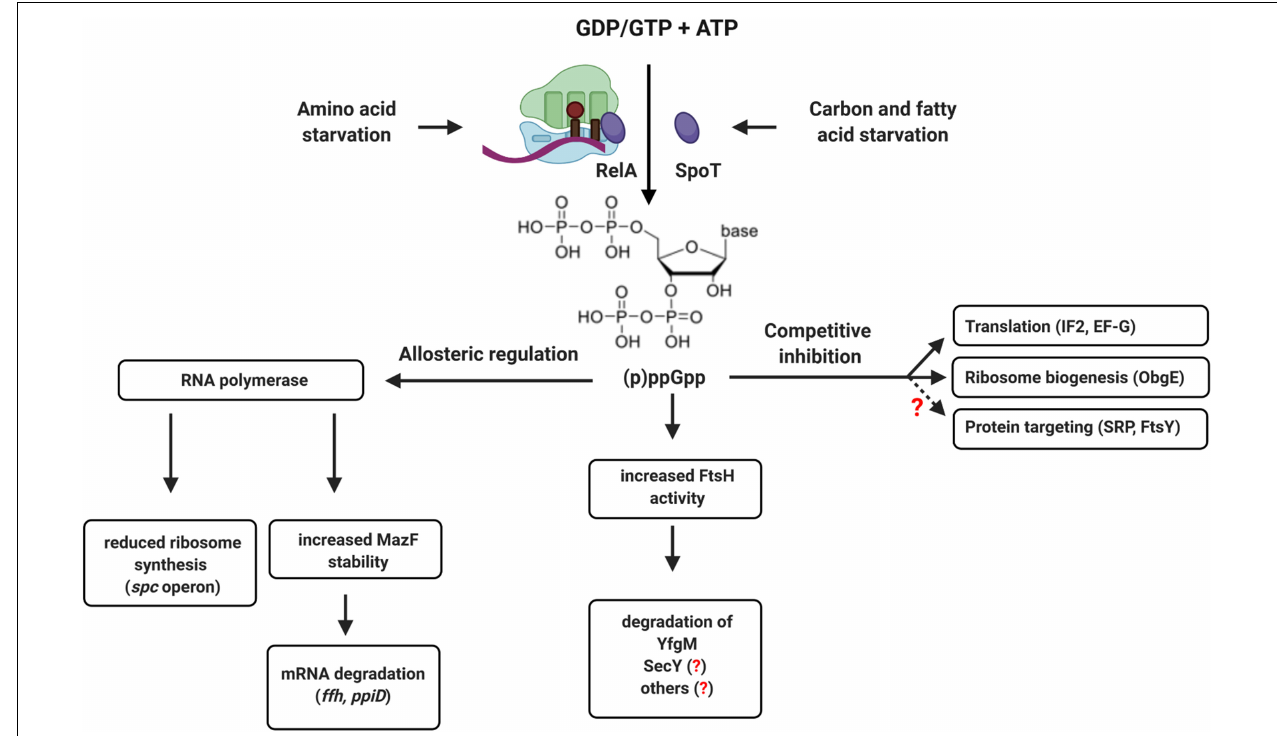
FIGURE 12 | (p)ppGpp-dependent regulation of translation and protein transport in bacteria. The alarmones ppGpp and pppGpp are synthesized upon amino acid starvation by the ribosome-associated protein RelA or by the cytosolic protein SpoT upon carbon or fatty acid starvation. Allosteric regulation of RNA polymerase by (p)ppGpp reduces ribosome biogenesis and increases the stability of the ribonuclease MazF, which degrades multiple mRNAs. This includes the mRNA encoding for Ffh, the protein component of the bacterial SRP, or the ppiD mRNA, encoding for an accessory subunit of the SecYEG translocon. (p)ppGpp also increases the activity of FtsH, which can degrade SecY and YfgM. YfgM forms a complex with PpiD that associates with the SecYEG translocon. Whether SecY is specifically degraded by FtsH upon (p)ppGpp accumulation is not shown yet. (p)ppGpp also acts as competitive inhibitor of GTP-binding proteins like translation factors (IF2 and EF-G) or ribosome biogenesis proteins (ObgE). This leads to reduced ribosome biogenesis and reduced translation upon stress. Although not yet experimentally shown, it appears likely that increasing (p)ppGpp concentrations also inhibit the two GTPases SRP and FtsY, which would fine-tune the protein targeting machinery to the reduced translation